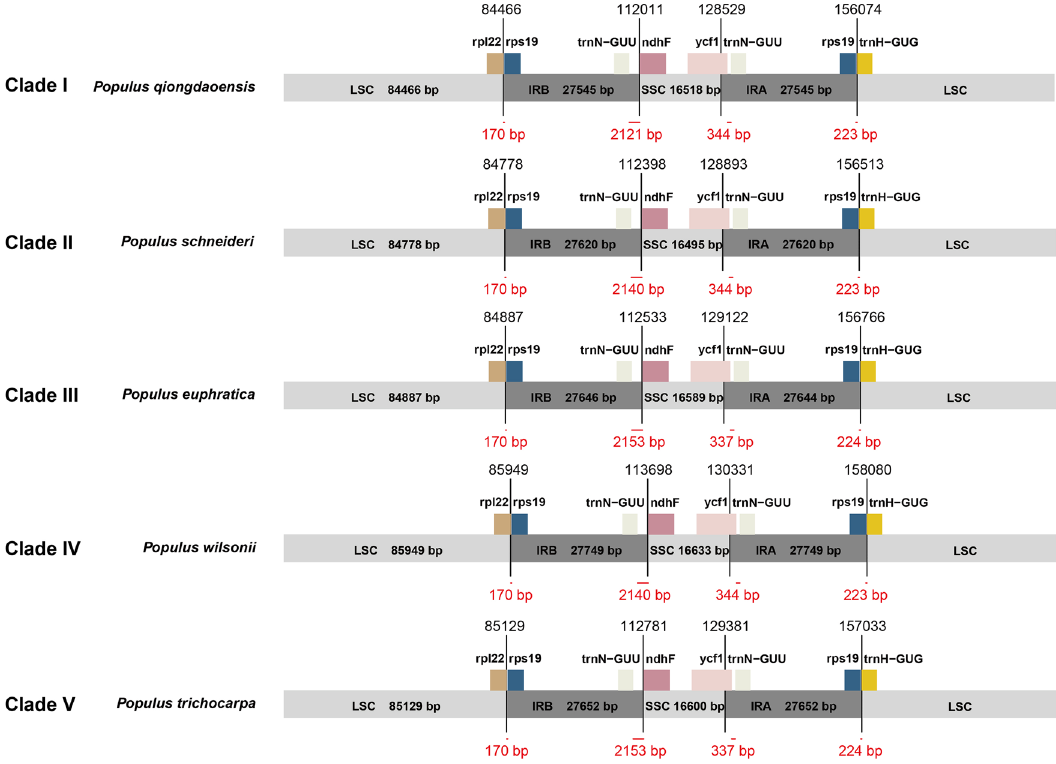
Figure 7. Comparison of junctions between the LSC, SSC, and IR regions among one exemplar species from each clade. Figure is not to scale. (LSC Large single-copy, SSC Small single-copy, IR inverted